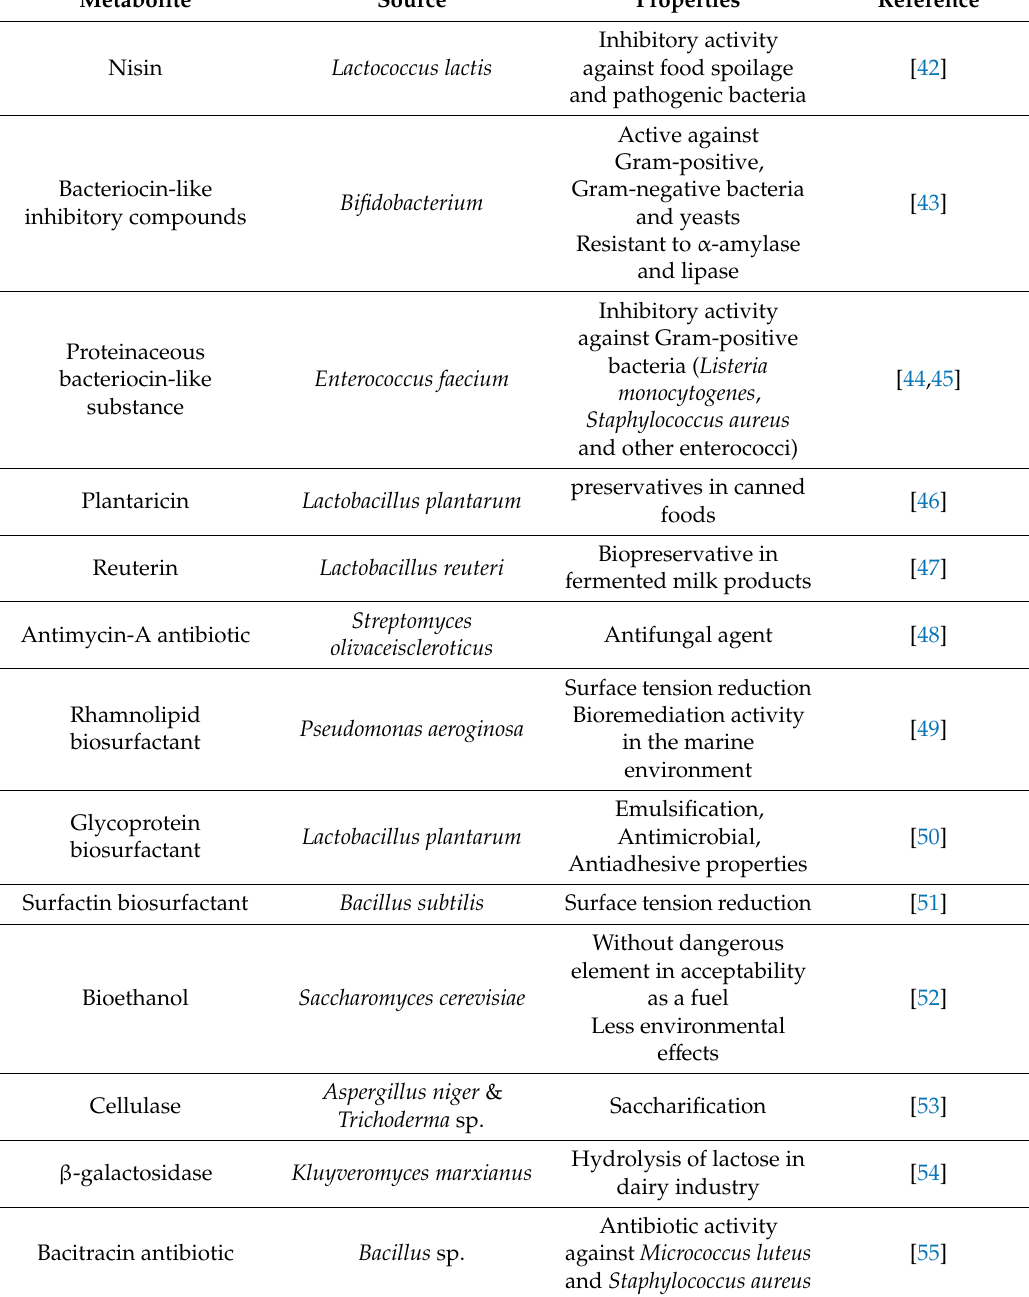
Table 1. Synthesized microbial